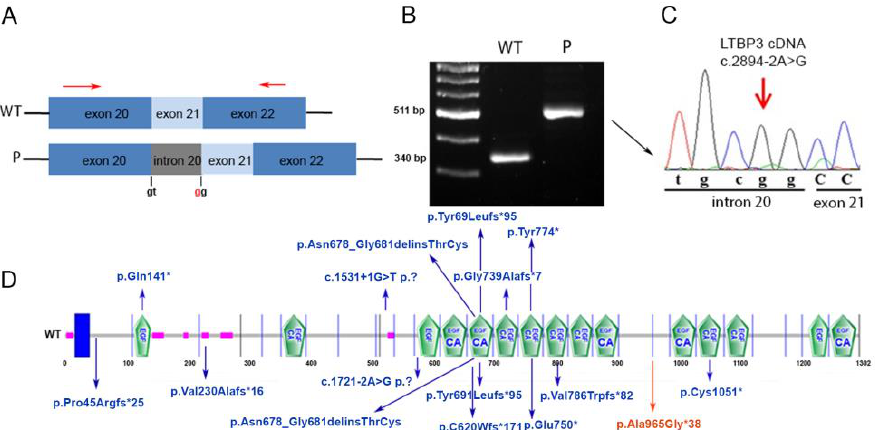
Figure 3. Characterization of the effect of the identified splicing variant c.2894-2A>G. ( A ) Schematic representation of the portion of the LTBP3 coding sequence encompassing exons 20–22. The c.2894-2A>G variant is located at the exon 21 acceptor splice site, promoting retention of intron 20. Arrows above the exons indicate the primers used for the cDNA analysis. ( B ) Gel electrophoresis analysis of the amplified cDNA stretch encompassing exon 21 showing an aberrant transcript size (511 bp) in the proband (P) indicating retention of intron 20. The length of a properly processed transcript is also shown for comparison (WT). The proband’s band was purified and Sanger sequenced. ( C ) chro- matogram showing the aberrant intron 20 retention. ( D ) Schematic diagram representation of the domain structure of the LTBP3 protein (NP_001123616.1) using the Simple Modular Architecture Research Tool (SMART: http://smart.embl.heidelberg.de, accessed on 1 December 2020) (above). In blue, the position of the previously identified homozygous pathogenic variants associated with DASS is shown. The presently identified pathogenic variation is shown in red.